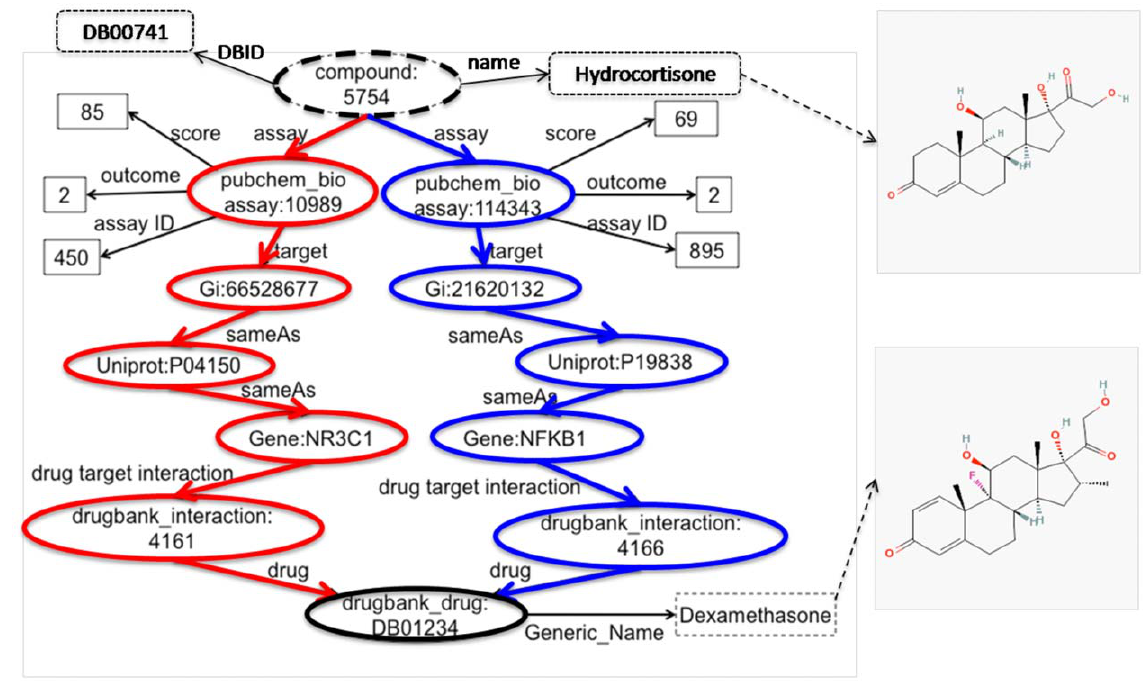
Figure 6. Graphic representation of the SPARQL query for finding the compound similar to Dexamethasone.